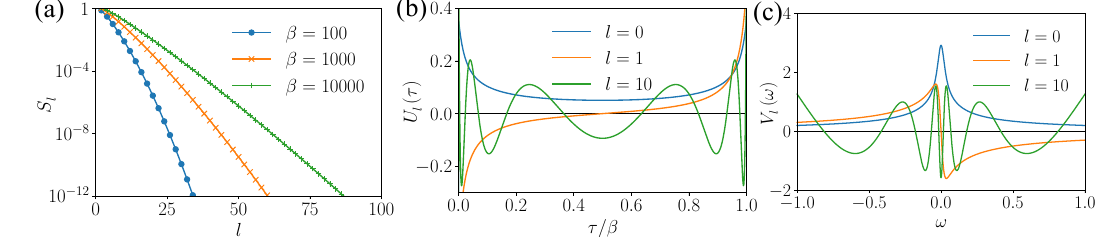
Figure 1: (a) Singular value S computed for various values of β . (b), (c) IR basis l ( τ ) and V ( ω ) computed for l = 0,1,10 and β = 100, respectively. ω functions U l l = is fixed at ω max